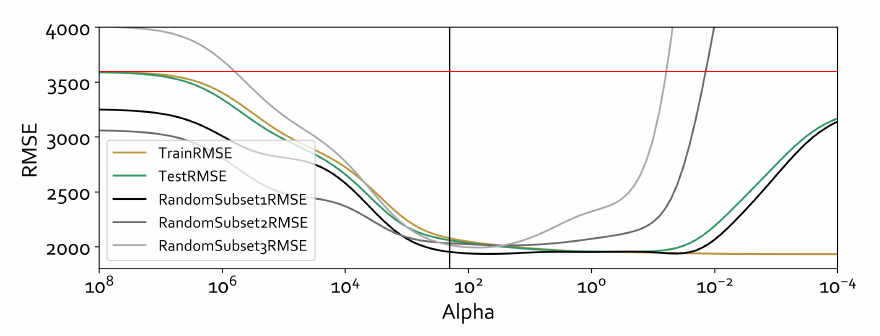
Figure 8. The RMSEs of the training and test subset in addition to the RMSEs of three random subsets (50 obs.) in relation to different levels of alpha, from large to small. Source: own